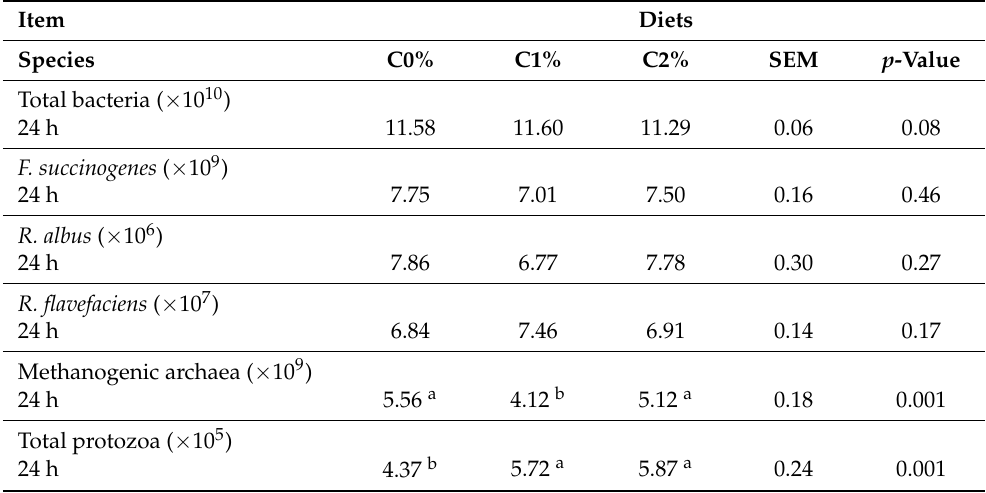
Table 6. The effect of dietary treatments of sampling on microbial population (copies/ mL) in vitro trial. Item Diets